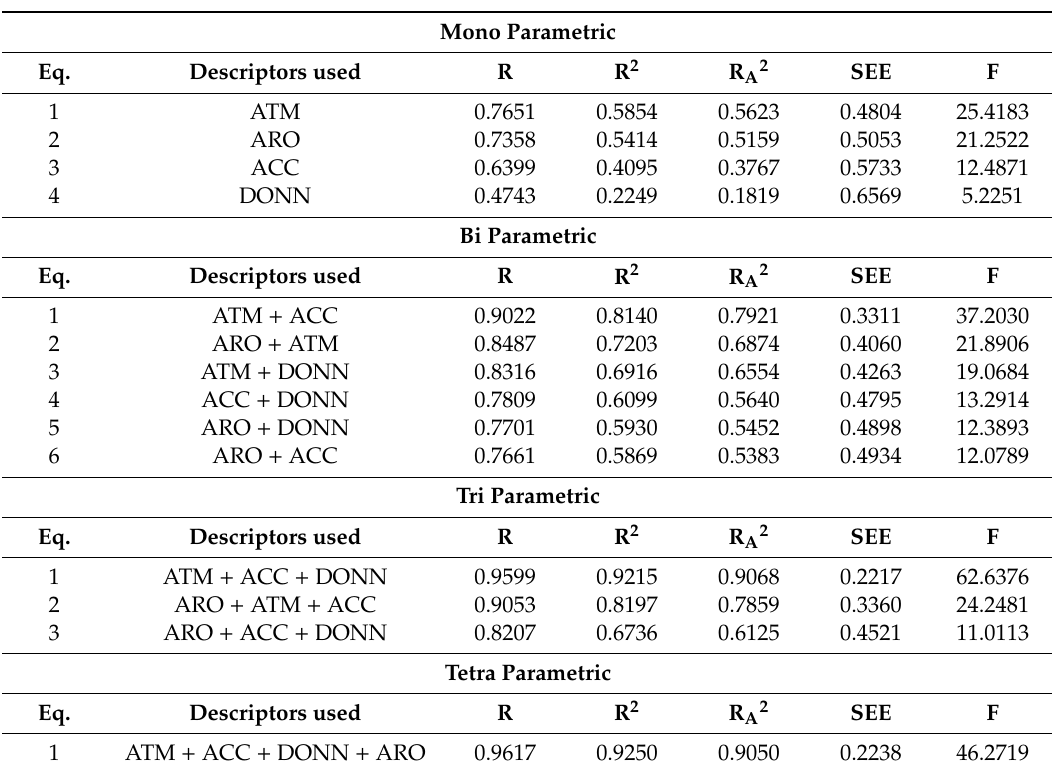
Table 2. Parametric models and regression analysis values (R: Correlation coefficient; R 2 : Correlation to square coefficient; R A2 : Correlation coefficient to adjusted square. SEE: Standard estimated error; F: Variance ratio).